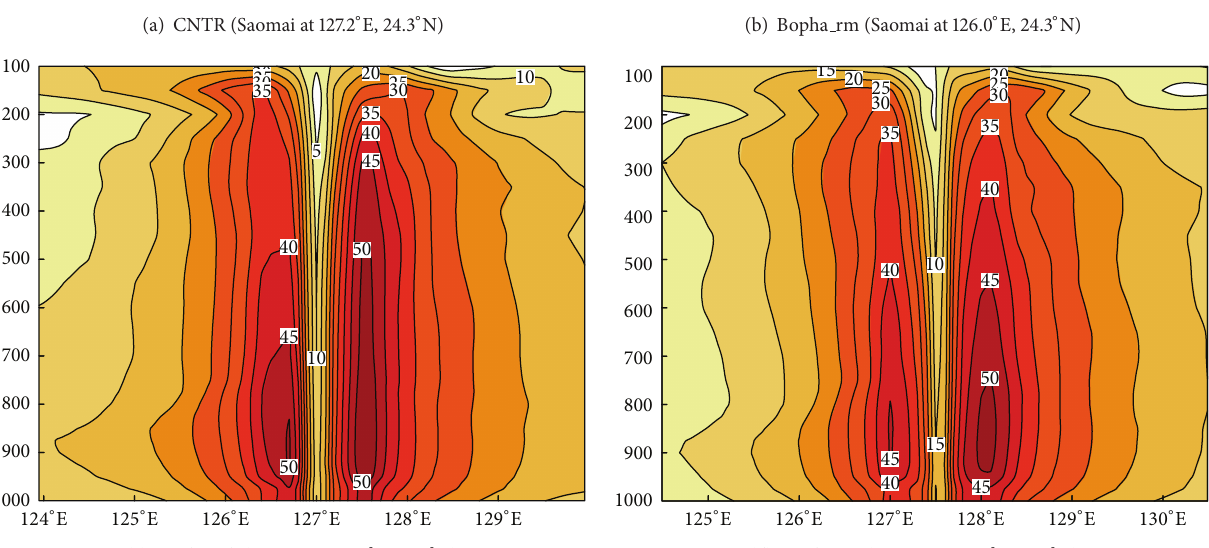
(d) Bopha str (Saomai at 127.5 ∘ E, 24.2 ∘ N) Figure 6: Horizontal wind of the meridional vertical cross-sections along the Saomai center (m/s, shaded) at the intensifying stage for CNTR (a), Bopha rm (b), Bopha wk (c), and Bopha str (d) at 0600 UTC 09 August,